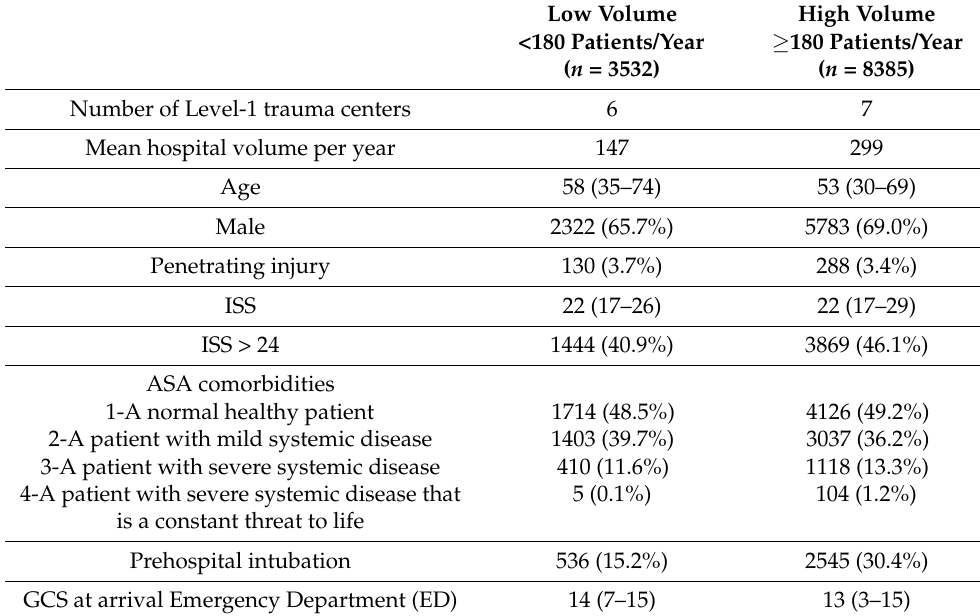
Table A1. Baseline characteristics of multiple imputed dataset 1 divided by low and high hospi- tal